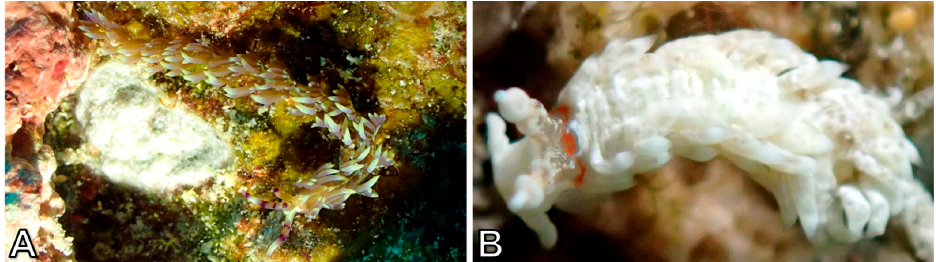
Figure 16. Nudibranchia - Cladobranchia: ( A ) Pteraeolidia semperi ; ( B ) Bulbaeolidia alba .